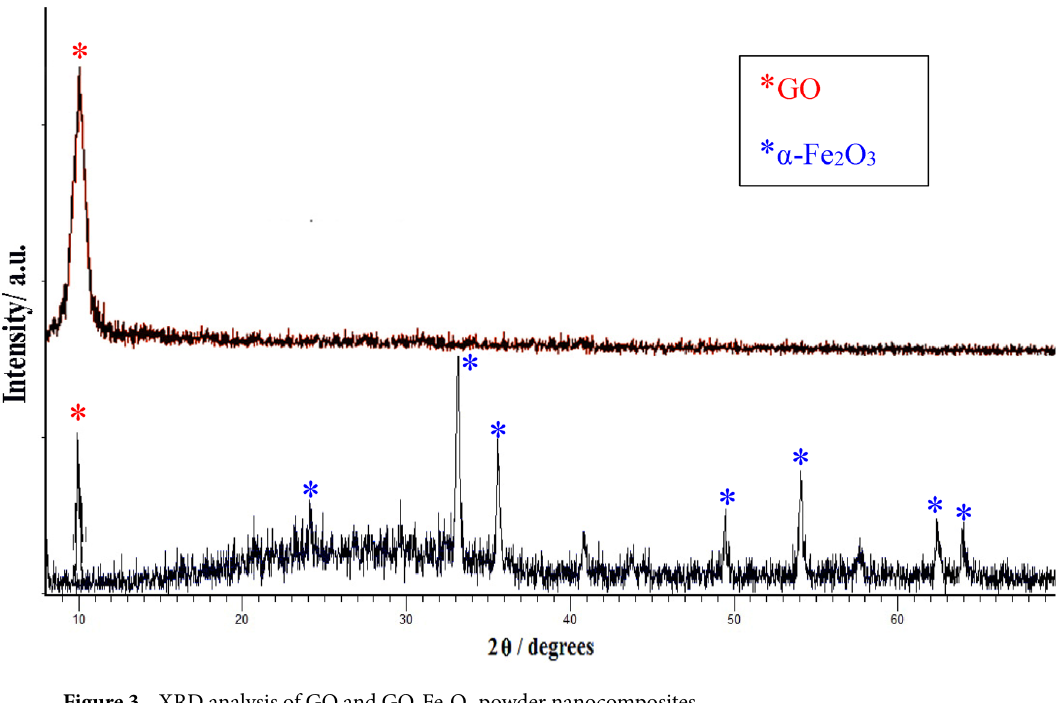
Figure 3. XRD analysis of GO and GO-Fe 2 O 3 powder nanocomposites.